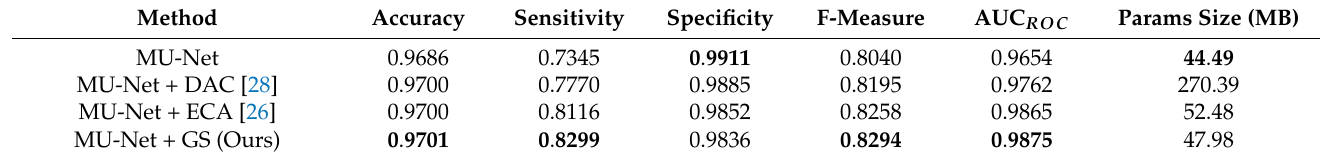
Table 1. Comparison of the proposed methods with other methods on the DRIVE dataset.